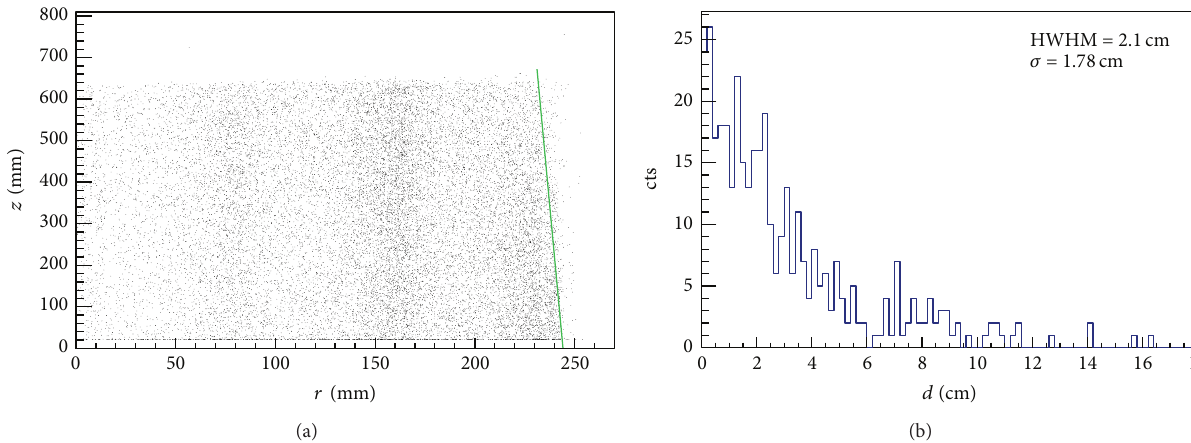
Figure 11: (a) Distribution of real events positions in the (𝑧,𝑟) plane, where 𝑧 is the distance from the liquid level and 𝑟 is the reconstructed radial coordinate, as derived from (𝑥,𝑦) information. The truncated-cone shape of the detector is well reproduced (upside-down in this view): = −61 ± 1.4 . Denser regions correspond once again to the the real slope, 𝑠 𝑟 = −62 , is to be compared with the one fitted from the data, 𝑠 rec radial positions of the photomultipliers. (b) Distribution of events wrongly reconstructed outside the detector walls, as a function of their distance 𝑑 from the walls (details in